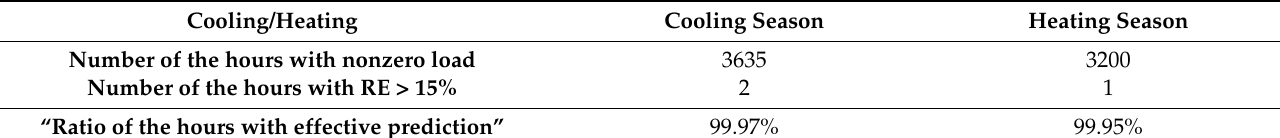
Table 10. “Ratio of the hours with effective prediction” on the scale of district